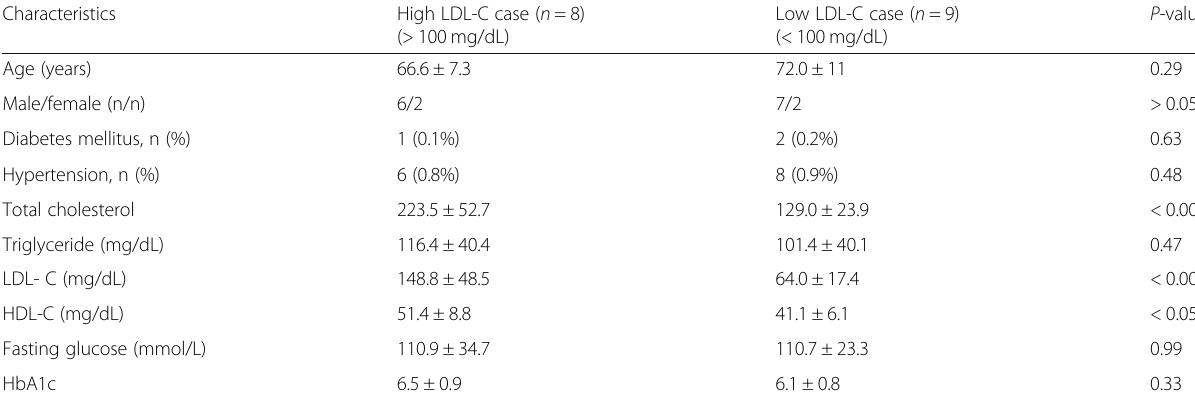
Table 2 Characteristics for the study population Characteristics